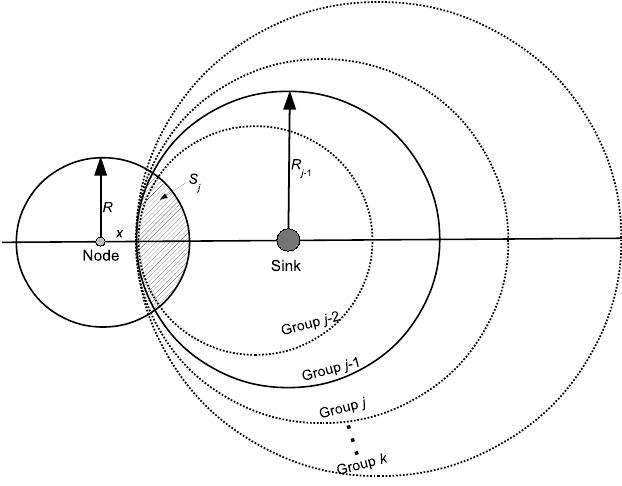
Figure 3. Intersection area with different